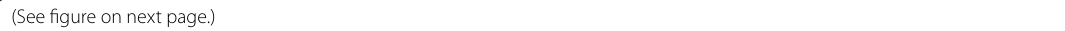
Fig. 7 Effects of 2 ′ ,3 ′ ,4 ′ ‑THC on ERα degradation and MAPK activity. A 2 ′ ,3 ′ ,4 ′ ‑THC does not compete for [ 3 H]‑E2 binding in MCF‑7 breast cancer cells. Competitive binding of 2 ′ ,3 ′ ,4 ′ ‑THC in the cells treated with 5 nM [ 3 H]‑E2 and increasing doses of 2 ′ ,3 ′ ,4 ′ ‑THC for 1 h at 37 °C. Specific [ 3 H]‑E2 binding was measured with a scintillation counter and calculated by subtracting non‑specific binding from total binding. The error bars are mean SE. B, C 2 ′ ,3 ′ ,4 ′ ‑THC does not alter ERα degradation, whereas SERMs prevent ERα degradation in MCF‑7 cells. B Western blot of MCF‑7 cells ± treated with 10 nM E2 in the absence and presence of 5 μM 2 ′ ,3 ′ ,4 ′ ‑THC, 10 μM tamoxifen (Tam), or 1 μM raloxifene (Ral) for the indicated time and then ERα and β‑actin protein levels were determined. C Quantification of ERα and β‑actin protein levels. The error bars are means differences among various treatments were analyzed with one‑way ANOVA. The asterisk over the bars indicates the significant difference between E2 alone and E2 in combination with 2 ′ ,3 ′ ,4 ′ ‑THC, Tam, or Ral at various times. D 2 ′ ,3 ′ ,4 ′ ‑THC inhibits E2 activation of MAPK. Active phospho‑p44/42 MAPK (top panel) and inactive p44/42 MAPK (bottom panel) were measured by western blotting after the cells were treated with 10 nM E2, 5 μM 2 ′ ,3 ′ ,4 ′ ‑THC alone or in combination for various times. E 2 ′ ,3 ′ ,4 ′ ‑THC does not alter EGF activation of MAPK. Active phospho‑p44/42 MAPK (top panel) and inactive p44/42 MAPK (bottom panel) were measured by western blotting after the cells were treated with 100 ng/ml EGF alone or in combination with 2 ′ ,3 ′ ,4 ′ ‑THC for various times. F Quantification of phospho‑p44/42 and p44/42 protein levels in E2‑treated cells. The asterisk over the bars indicates the significant difference between E2 alone and E2 in combination with 2 ′ ,3 ′ ,4 ′ ‑THC. G Quantification of phospho‑p44/42 and p44/42 protein levels in EGF‑treated cells. Quantification of protein levels of western blots was done by ImageJ . The asterisks indicate a significant difference between the control and EGF‑treated